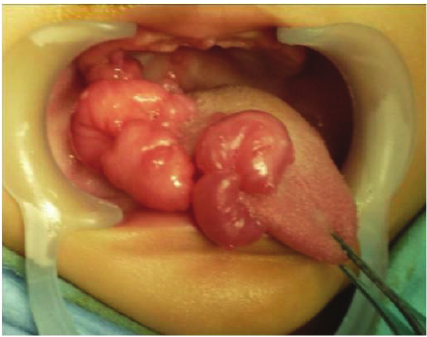
Figure 3: Immunohistochemical characteristics of the vascular leiomyomas. The immunohistochemical study revealed the expres- sion of vimentin, desmin, muscle specific actin, and smooth muscle actin within the tumor cells.